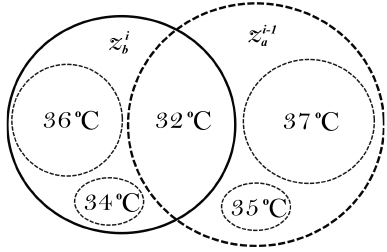
Figure 1. Two zones touch each other apparently but they have no association essentially since their areas equaling to the maximum temperature are not in the overlapping area.